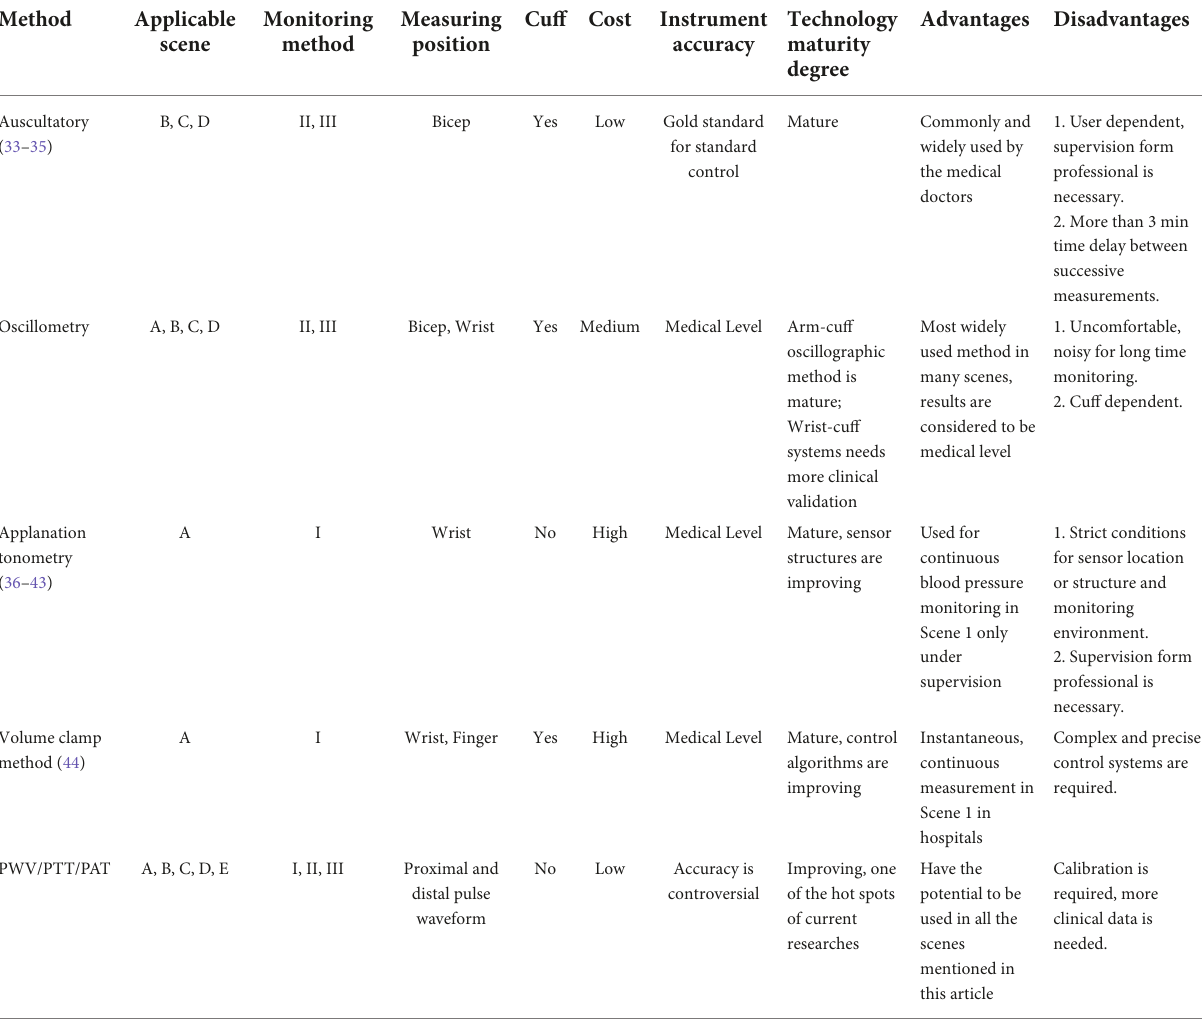
TABLE 1 A comparative point of view for different blood pressure (BP) monitoring methods in multi-scenes. Applicable scene: scene 1 (A): lay down, scene 2 (B): sit, scene 3 (C): walk around, scene 4 (D): sports, scene 5 (E): special